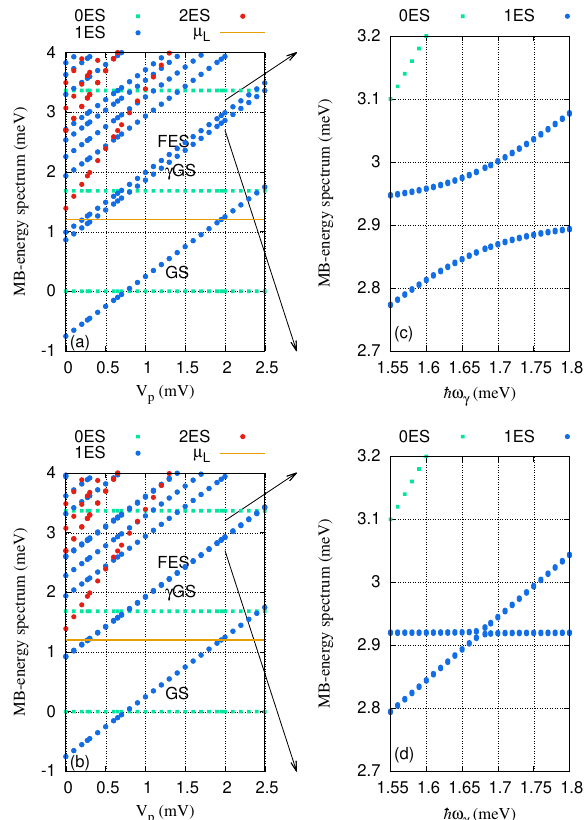
Figure 8. Many-body (MB) energy of the QD system versus the gate voltage (V p ), for the x - ( a ) and y -polarized ( b ) photon fields. The MB energy spectrum of the γ GS and FES versus photon energy is plotted for x - ( c ) and y -polarized ( d ) photon fields. The 0ES (green squares) are zero-electron states, 1ES (blue circles) are one-electron states, and 2ES (red circles) are two-electron states. The golden line is the chemical potential of the leads where µ L = µ R = µ = 1.2 meV. GS indicates the one-electron ground-state, γ GS is the one-photon replica of the one-electron ground-state, and FES is the one-electron first-excited state. The photon energy ¯ h ω γ = 1.68 meV, and g γ = 0.05 meV. The magnetic field is B = 0.1 T, and ¯ h Ω 0 = 2.0 meV.